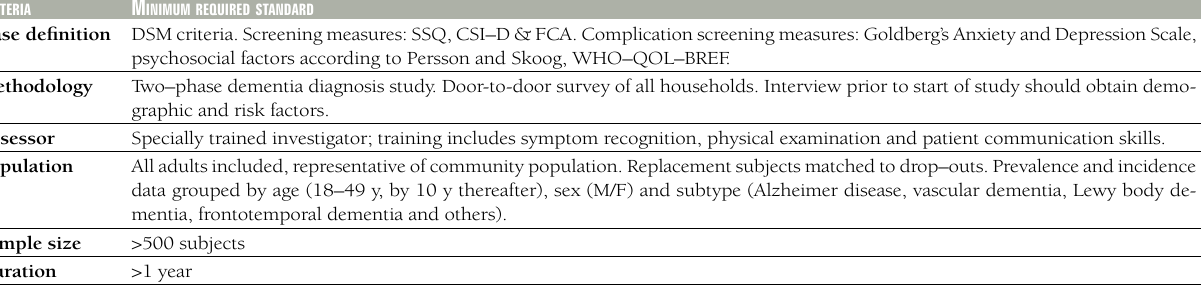
Table 9 Recommended criteria for future studies of dementia in the community C